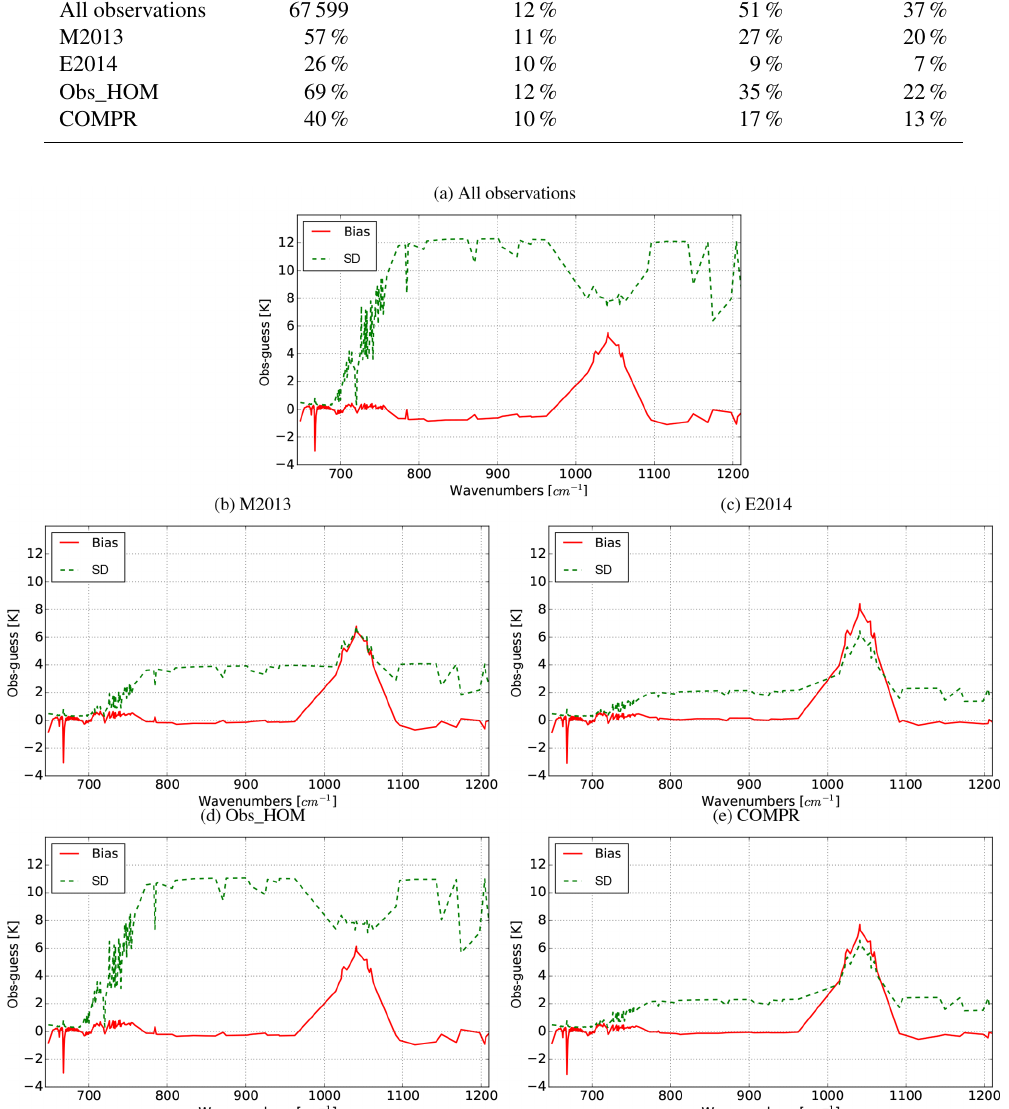
Figure 3. Bias (red solid line) and standard deviation (green dashed line) in kelvin (K) of the differences between IASI observations and background simulations using RTTOV-CLD and a 6h forecast: (a) for the whole dataset, (b) after applying the homogeneity criteria derived from Martinet et al. (2013), (c) after applying the homogeneity criteria derived from Eresmaa (2014), (d) after applying the selecting ho- mogeneous scenes based on observation space, (e) after applying the compromise to select the homogeneous scenes. Observations are for 30 January